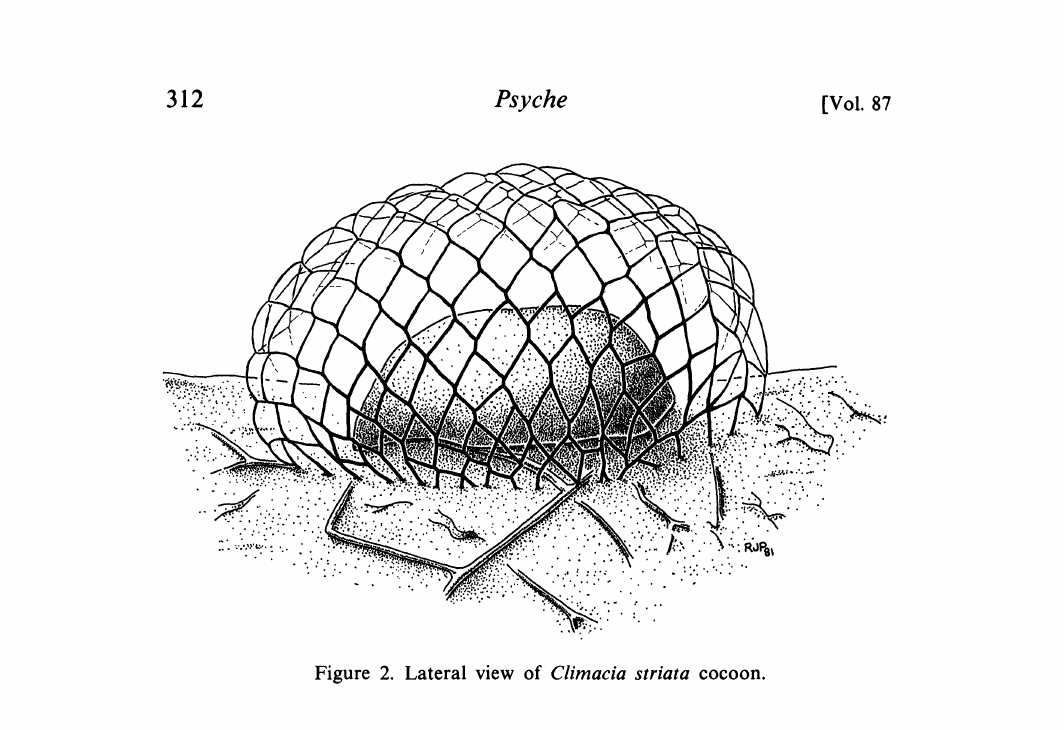
Figure 2. Lateral view of Climacia striata